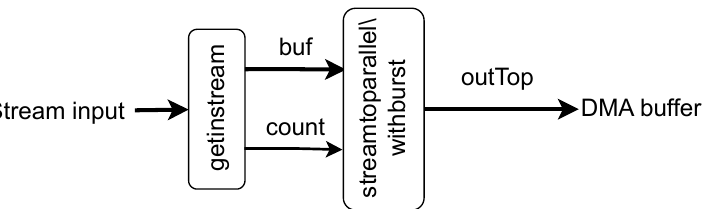
Figure 6. Structure of the AMD/Xilinx code implementing the transfer of the AXI-Stream packet to the DMA